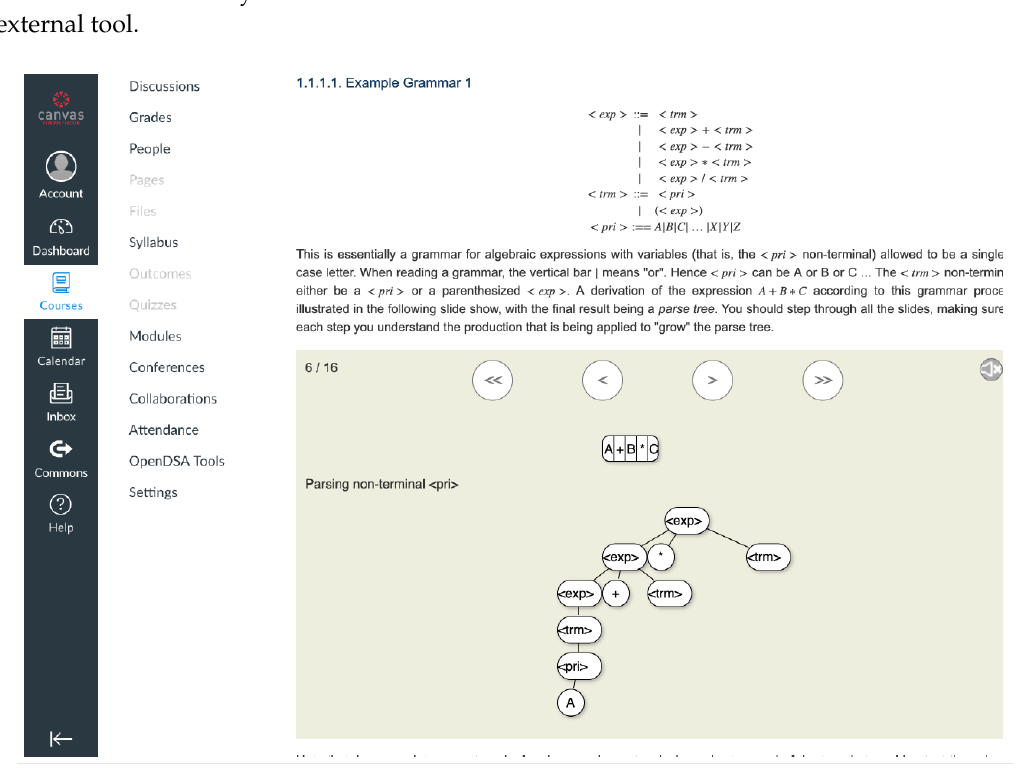
Figure 2. An OpenDSA module delivered in